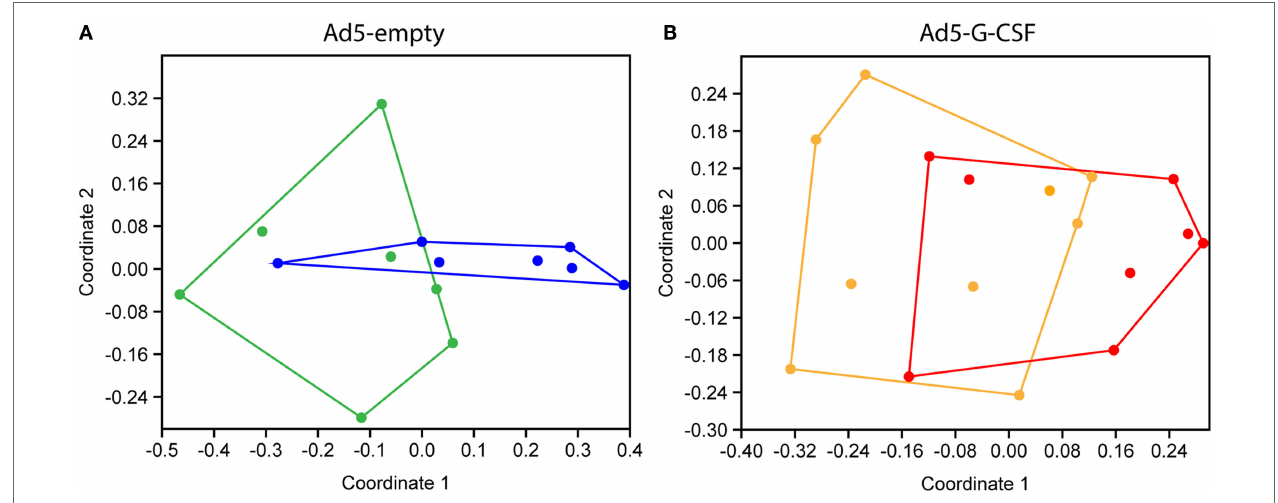
FigUre 4 | non-metric multidimensional scaling (nMDs) analyses of 16s rrna gene OTUs from Salmonella -challenged pigs with prior administration of ad5-empty (a) or ad5-g-csF (B) . Shown are the fecal microbiotas from samples taken at 3 days [ (a) , green; (B) , orange] and 7 days [ (a) , blue; (B) , red] post- Salmonella challenge. OTU cutoff of 97% similarity was used. Stress = (a) , 0.1445; (B) ,